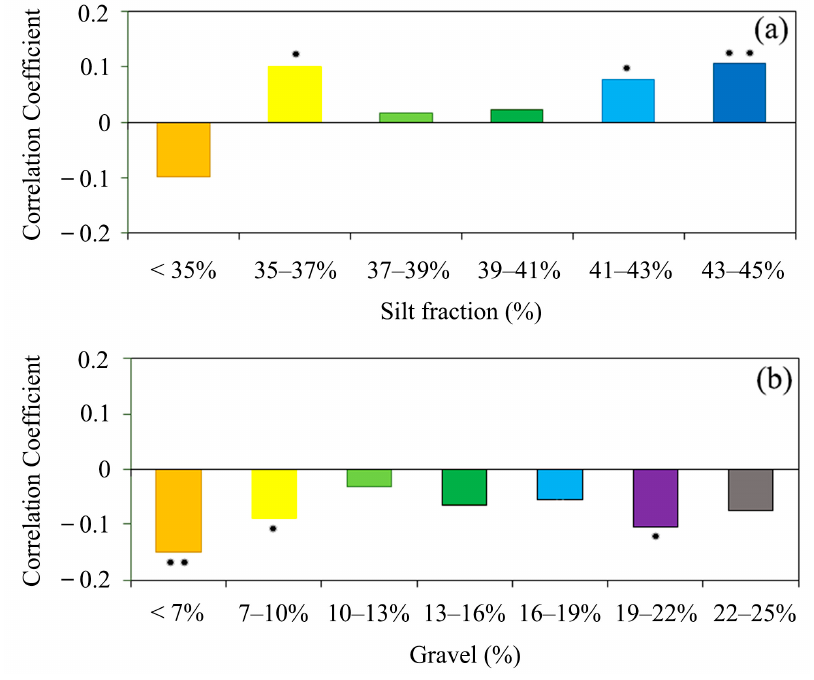
Figure 13. Relationships between silt soil fraction and AI ( a ), and gravel fraction and AI ( b ).